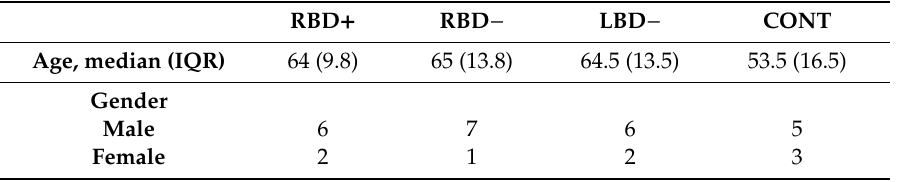
Table 1. Age and gender of the eight participants in each